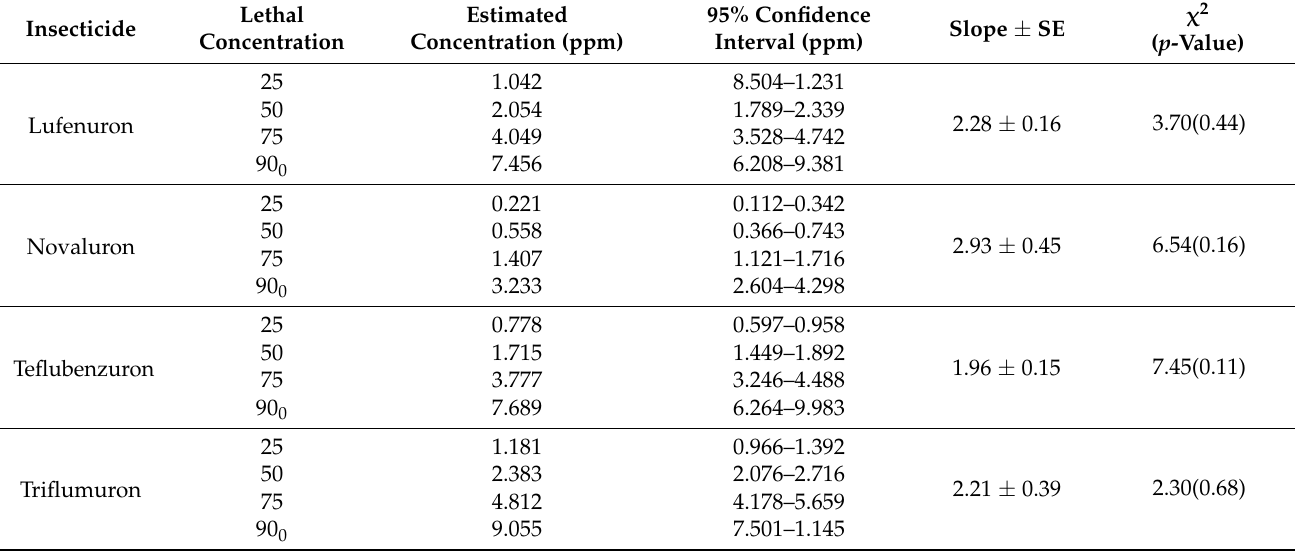
Table 1. Lethal concentration of four benzoylphenyl ureas (BPUs) against Leptopharsa gibbicarina nymphs after 72 h exposure, obtained from probit analysis (df = 5). The chi-square ( χ 2 ) value refers to the goodness of fit test at p > 0.05. Insecticide